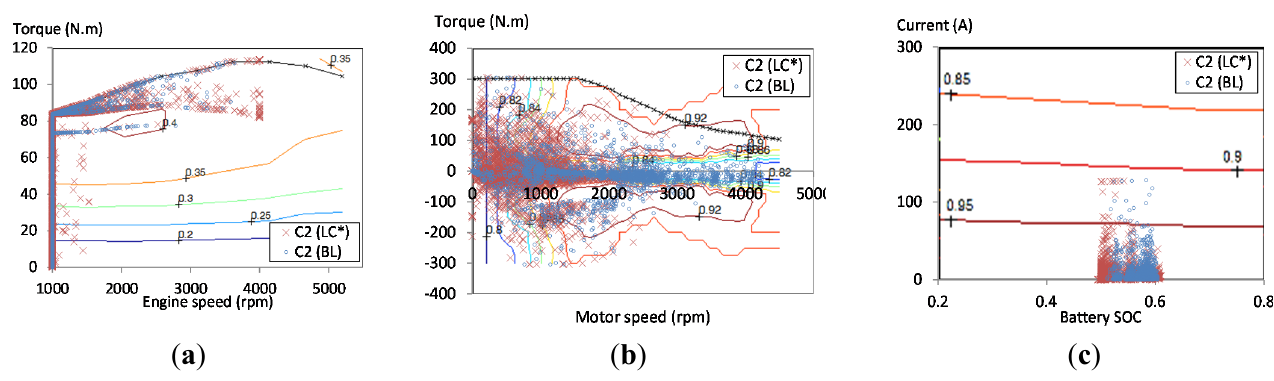
Figure A5. Plots of C2 solution engine ( a ), electric motor ( b ), and battery ( c ) operation for BL and LC driving cycles. (* driving cycle used in the